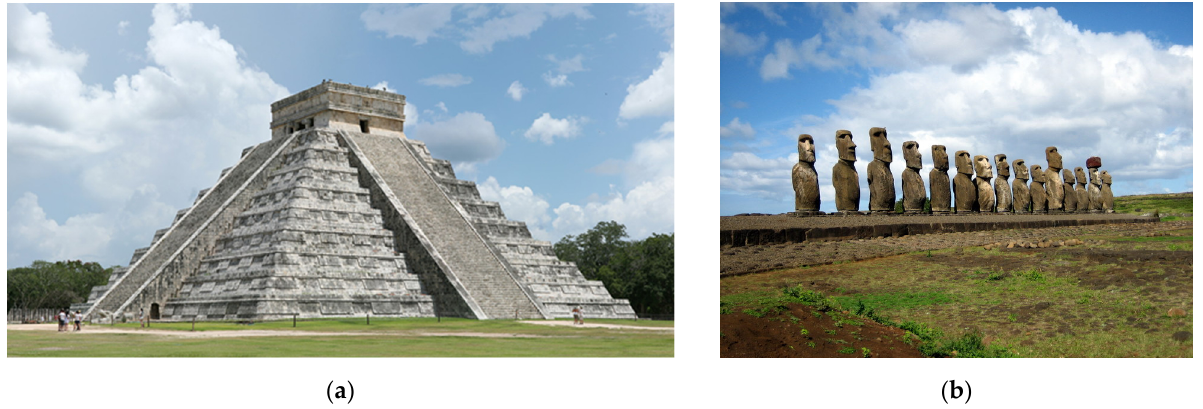
Figure 11. ( a ) Maya: El Castillo, at Chichen Itza [152] ( b ) Moai facing inland at Ahu Tongariki, restored by Chilean archaeologist Claudio Cristino in the 1990s [153].